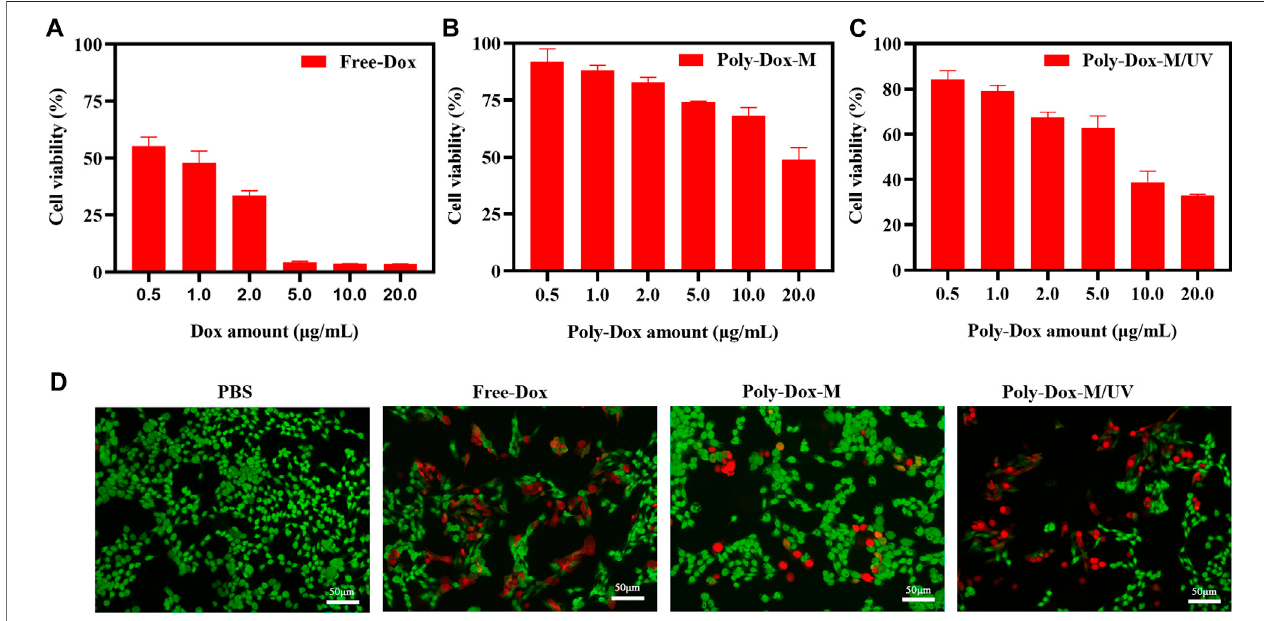
FIGURE3| CellviabilityofK7M2-wtcellstreatedwith (A) Free-Dox. (B) Poly-Dox-Mand (C) Poly-Dox-MunderUVirradiationatavariousdoseofDoxorPoly-Dox. (D) K7M2-wt cells stained by calcein-AM (green) and PI (red) after 6 h incubation with PBS, free Dox, Poly-Dox-M under UV irradiation or not. Blue signal represents live cell, red signal represents dead cell. Scale bar: 50 μ